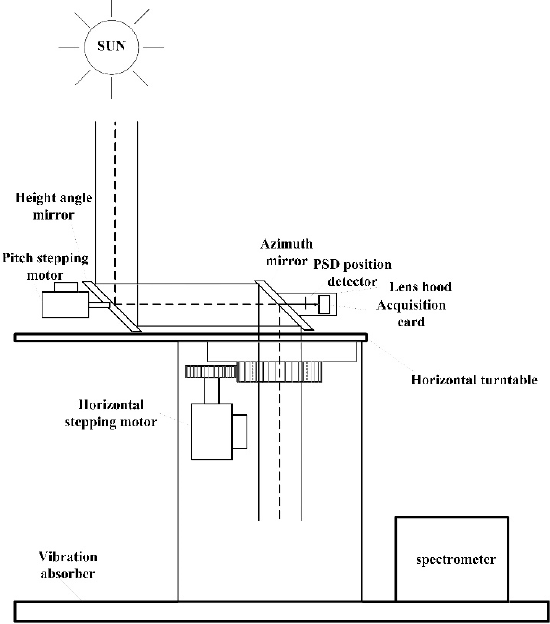
Figure 2. Layout Diagram of Solar Tracking System.